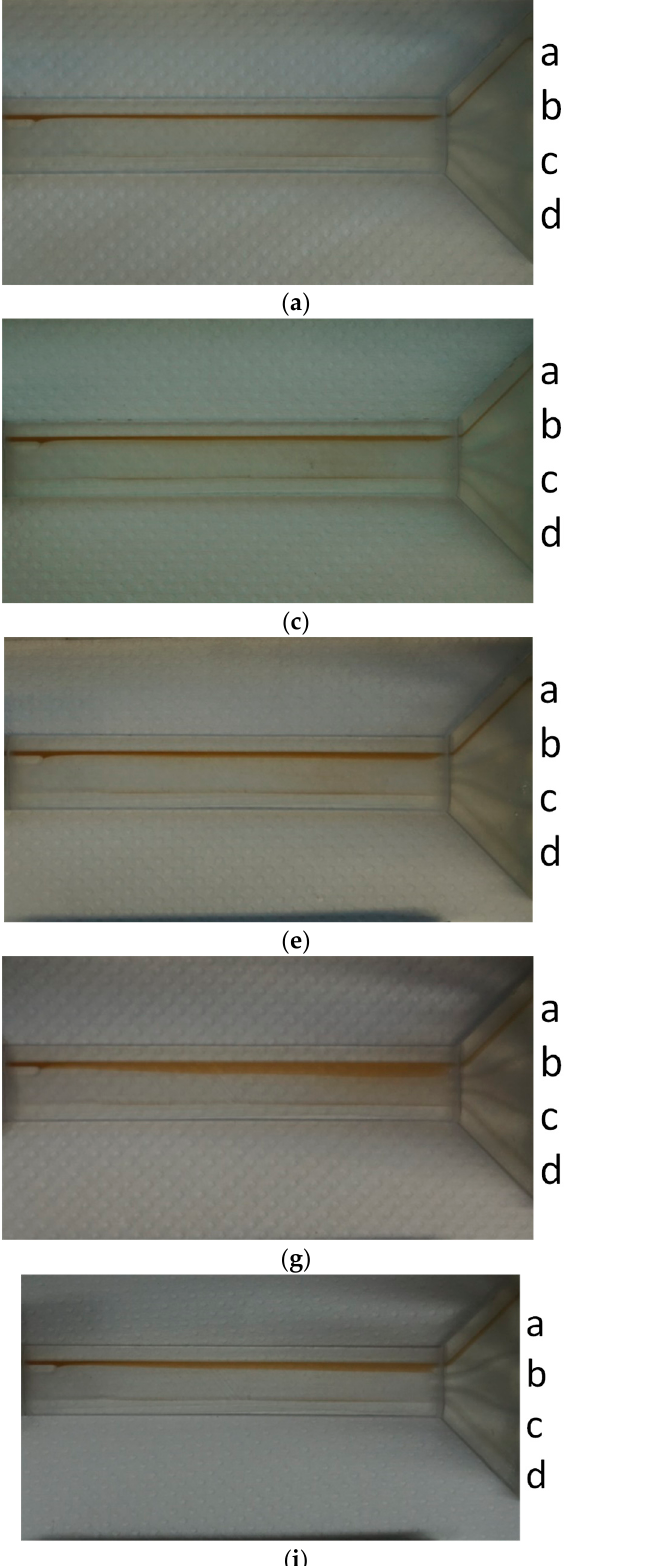
Figure 5. Separation of bare MNPs at pH 7 without ( a ) and with ( b ) magnet. Separation of bare MNPs at pH 8 without ( c ) and with ( d ) magnet. Separation of bare MNPs at pH 9 without ( e ) and with ( f ) magnet. Separation of bare MNPs at pH 10 without ( g ) and with ( h ) magnet. Separation of bare MNPs at pH 11 without ( i ) and with ( j )